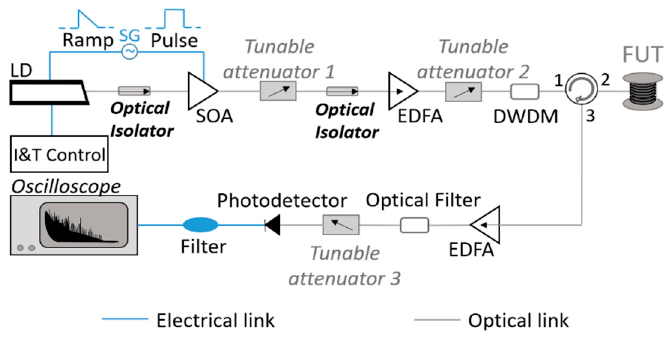
Figure 3. Chirped-pulse phase-sensitive OTDR setup (CP- φ OTDR): acronyms are explained within the text.